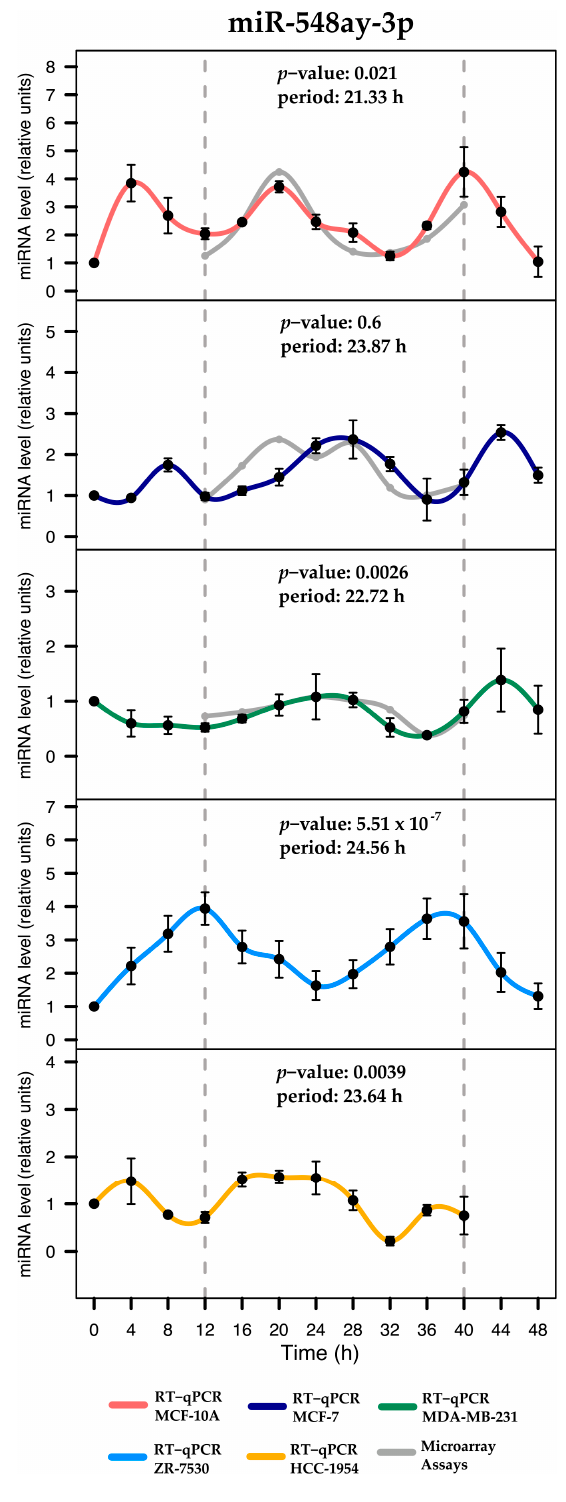
Figure 5. Expression profiles of miR-548ay-3p across breast cell lines. Rhythmic expression was evaluated using RT-qPCR in serum-shocked MCF-10A, MCF-7, MDA-MB-231, ZR-7530, and HCC-1954 cells over 48 h (4 h intervals). Data points (means of three biological replicates ± SEM) were normalized using miR-106a-5p relative to the first time point ( t = 0). The p -values and period values of rhythmic profiles were obtained from MetaCycle analysis and are illustrated at the top of each plot. For comparison purposes, the gray line illustrates the expression profiles obtained from microarray assays, which were scaled to the expression profiles obtained from RT-qPCR assays. Dashed gray lines at 12 and 40 h were added to show the period in which the profiles were measured by microarrays.